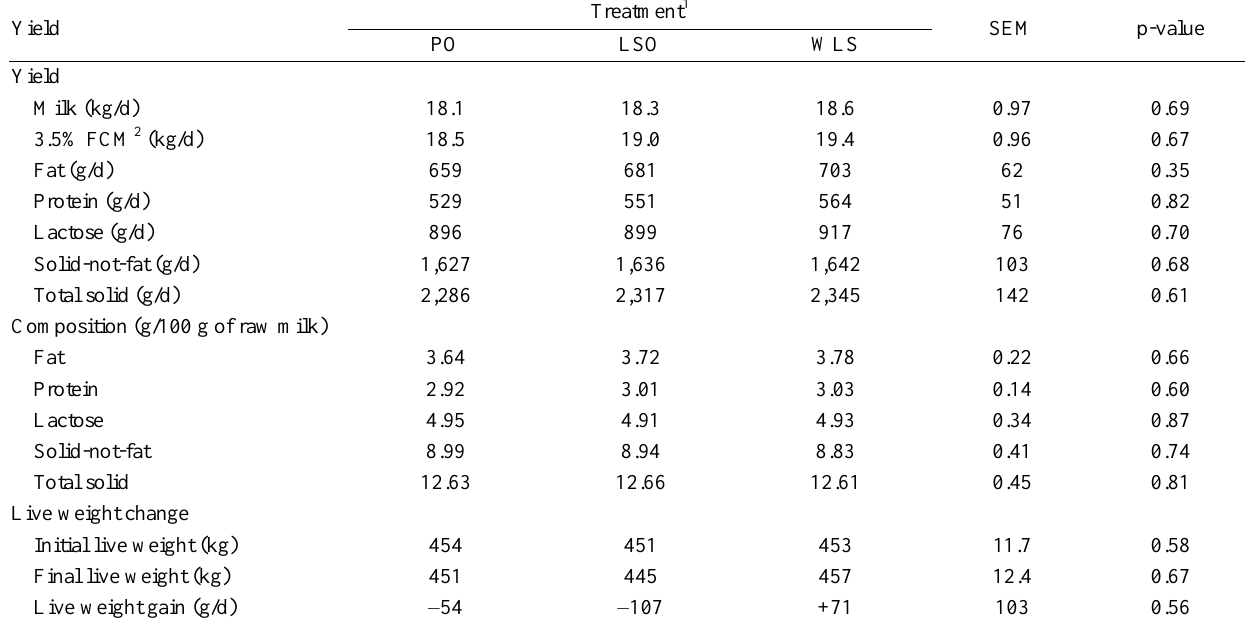
Table 4. Effects of treatment diets on milk yield, milk composition, and live weight change